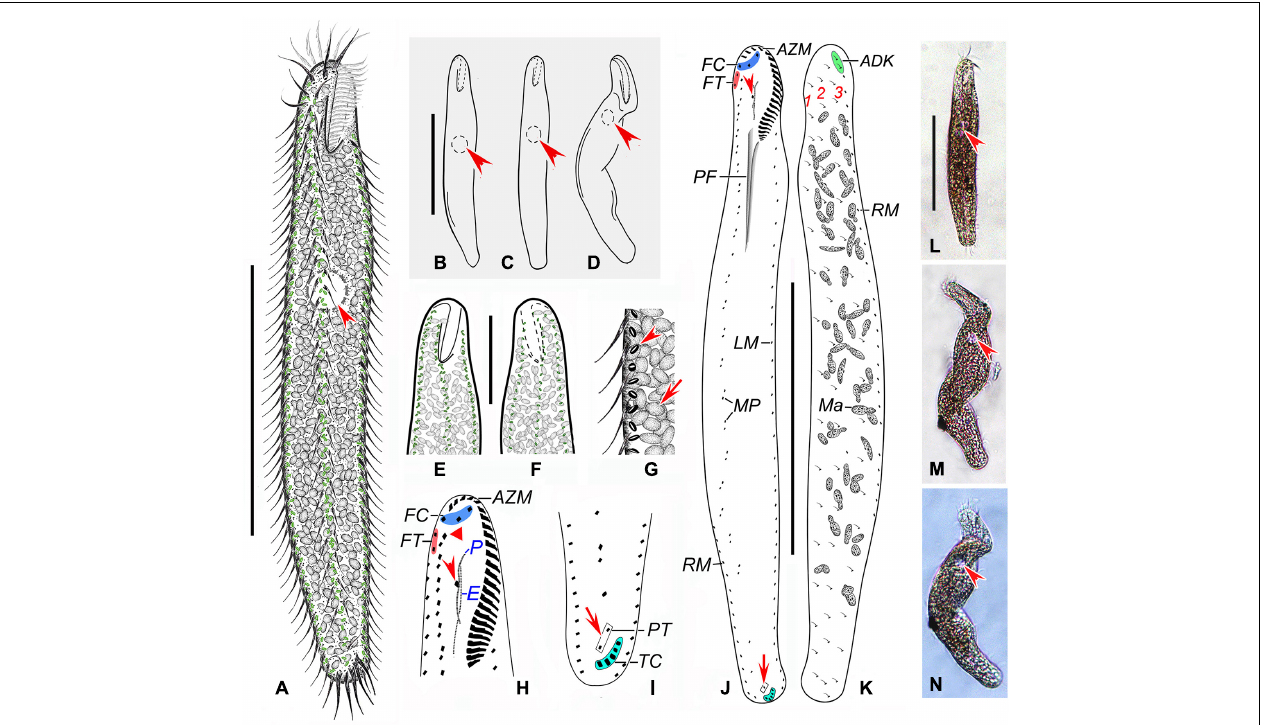
FIGURE 4 | Anteholosticha perezuzae sp. nov. from life (A–G,L–N) and after protargol impregnation (H–K) . (A–D) Overviews, showing the different body shapes and flexibility, arrowheads mark the contractile vacuole. (E–G) Ventral (E,G) and dorsal (F) views of the surface, showing the arrangement of slightly biconcave-shaped cortical granules (arrowhead) and packed ellipsoidal structures, likely mitochondria (arrow). (H) Ventral view of anterior part of cell, showing buccal cirrus (arrowhead) and parabuccal cirrus (red triangle). (I) Ventral posterior view, showing pretransverse cirri (arrow) and transverse cirri (light-blue part). (J,K) Ventral (J) and dorsal (K) views of the holotype specimen, showing the ciliary pattern and the nuclear apparatus; arrowhead marks buccal cirrus and arrow indicates the pretransverse cirrus. (L–N) Overviews of different specimens; arrows indicate contractile vacuole. ADK, additional dorsal bristles at anterior end of the right marginal cirral row; AZM, adoral zone of membranelles; E, endoral membrane; FC, frontal cirri; FT, frontoterminal cirri; LM, left marginal cirral row; Ma, macronuclear nodules; MP, midventral cirral pairs; P, paroral membrane; PF, pharyngeal fibers; PT, pretransverse cirri; RM, right marginal cirral row; TC, transverse cirri; 1–3, dorsal kineties 1–3. Scale bars = 110 µ m (A–D,J–N) , 70 µ m (E,F)